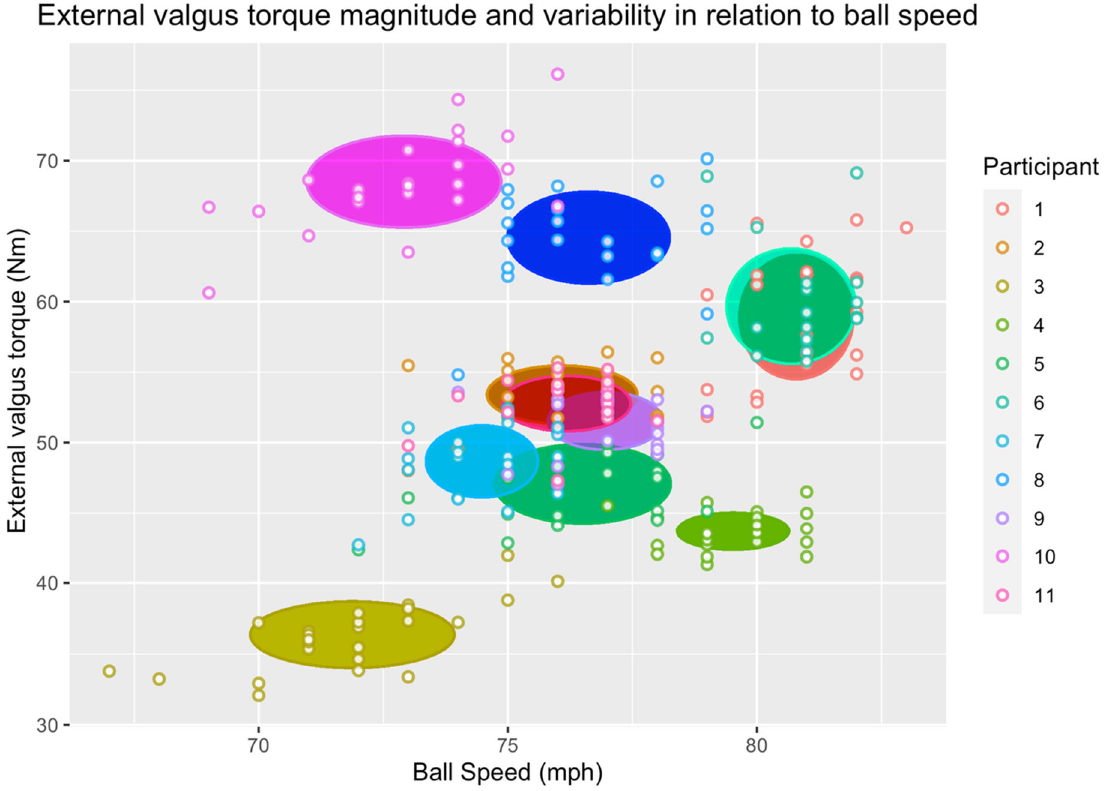
Figure 3. The relationship between ball speed and valgus torque. Every dot is a single pitch of a participant. Each color represents a participant, corresponding with the colors in Figure 1. The ellipses show the within-individual external valgus torque variability and the ball speed variability. The height of the ellipse is twice the standard deviation of individual scores of the external valgus torque, and the width of the ellipse is twice the ball speed standard deviation. The center of the ellipse is the mean of the scores of the external elbow valgus torque and ball speed of a single